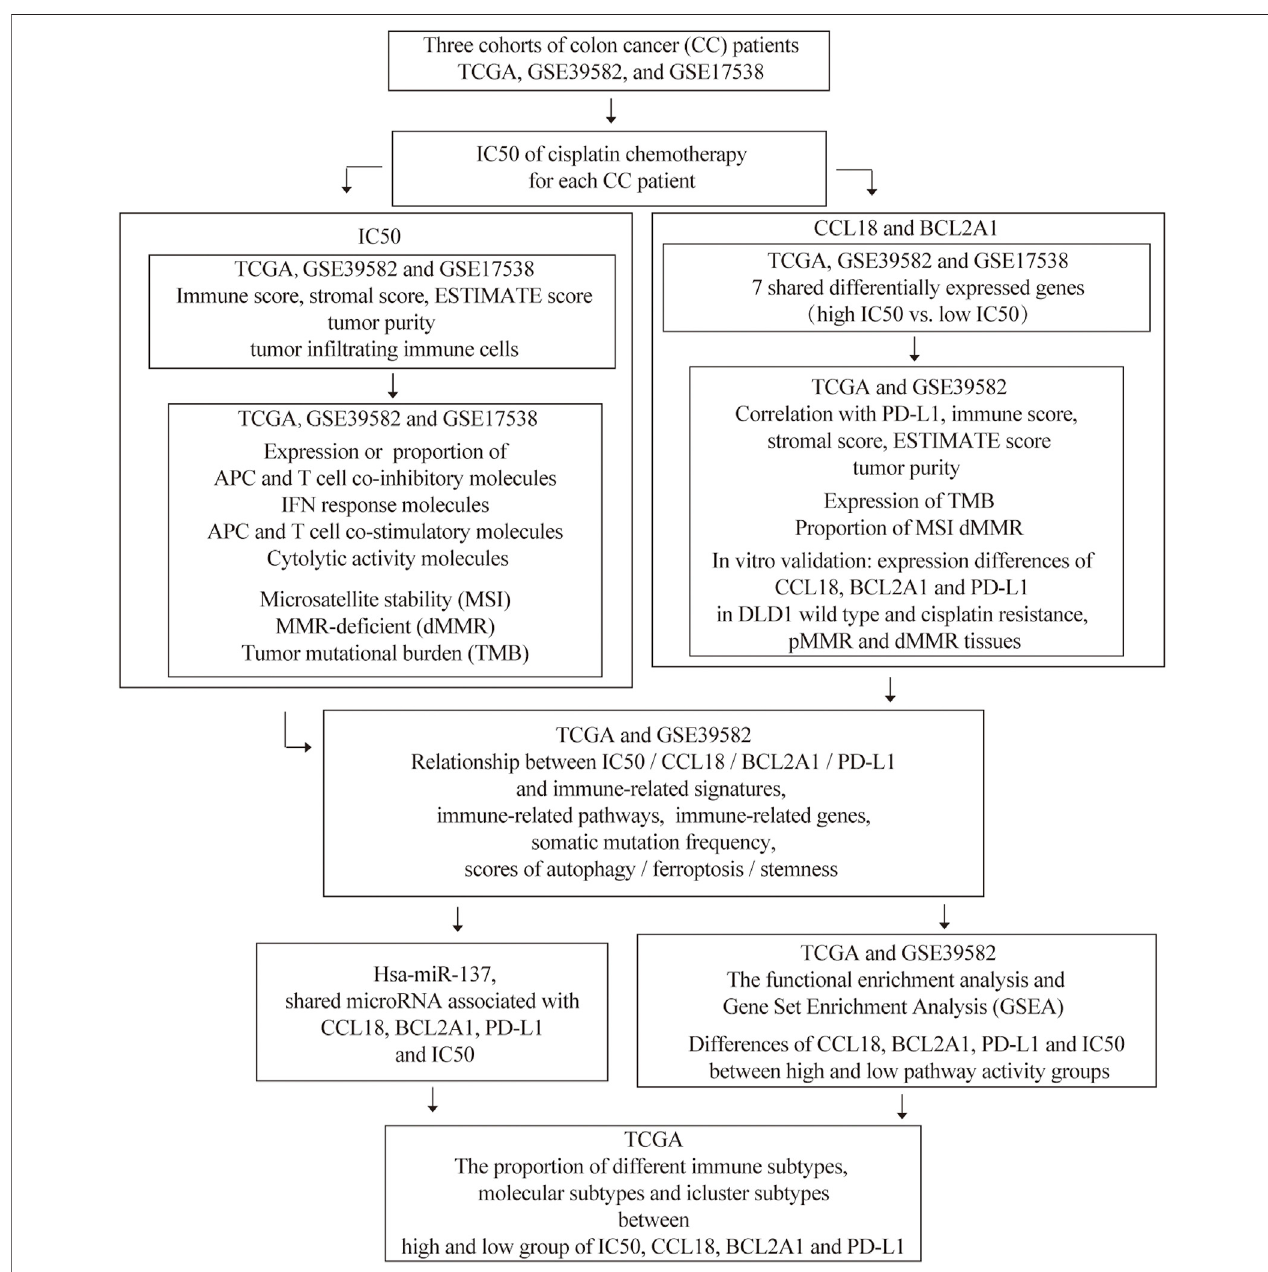
FIGURE 1 | The fl owchart of our